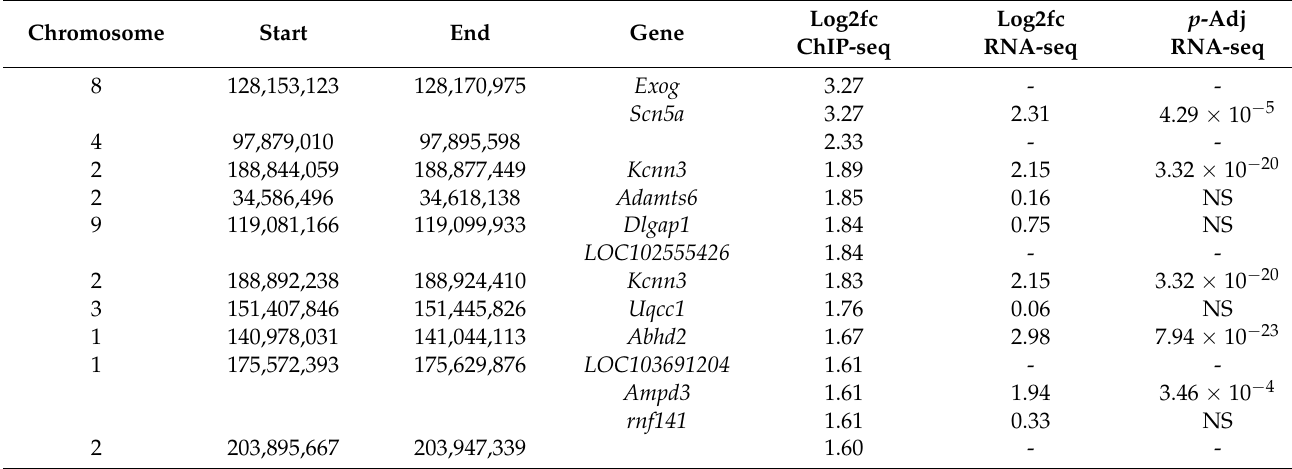
Table 2. Top ten activated super enhancers upon denervation. Super enhancers were sorted by the log2FC of the average value of H3K27ac enrichment. Change in H3K27ac enrichment in the super enhancer delimited region (log2FC ChIP-seq), effect on the expression of the genes localized near the super enhancer region (log2FC RNA-seq) and their significance ( p -adj